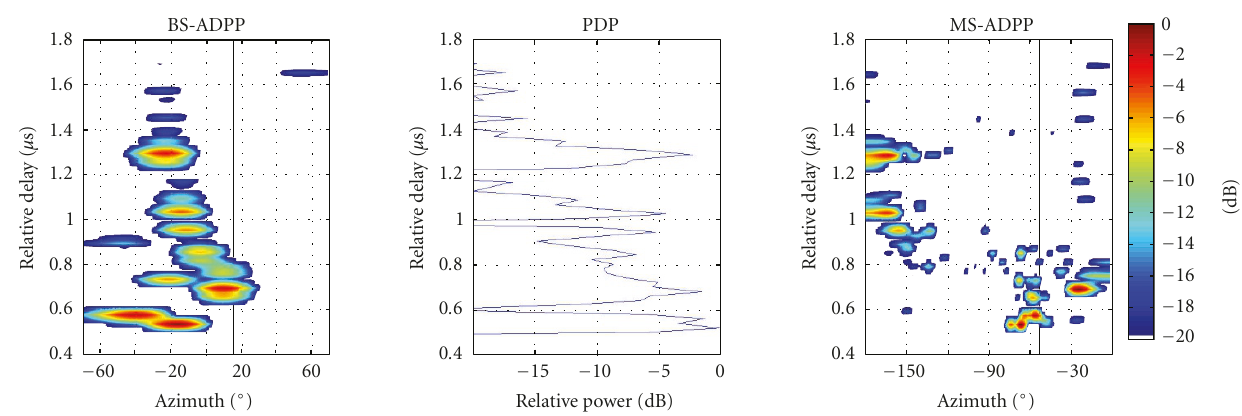
(1) BS-ADPP and MS-ADPP processing with a conven- tional beamforming approach, applied to the measurement data (Figure 12(a)). (2) Channel parameter estimation trough detection of lo- cal power